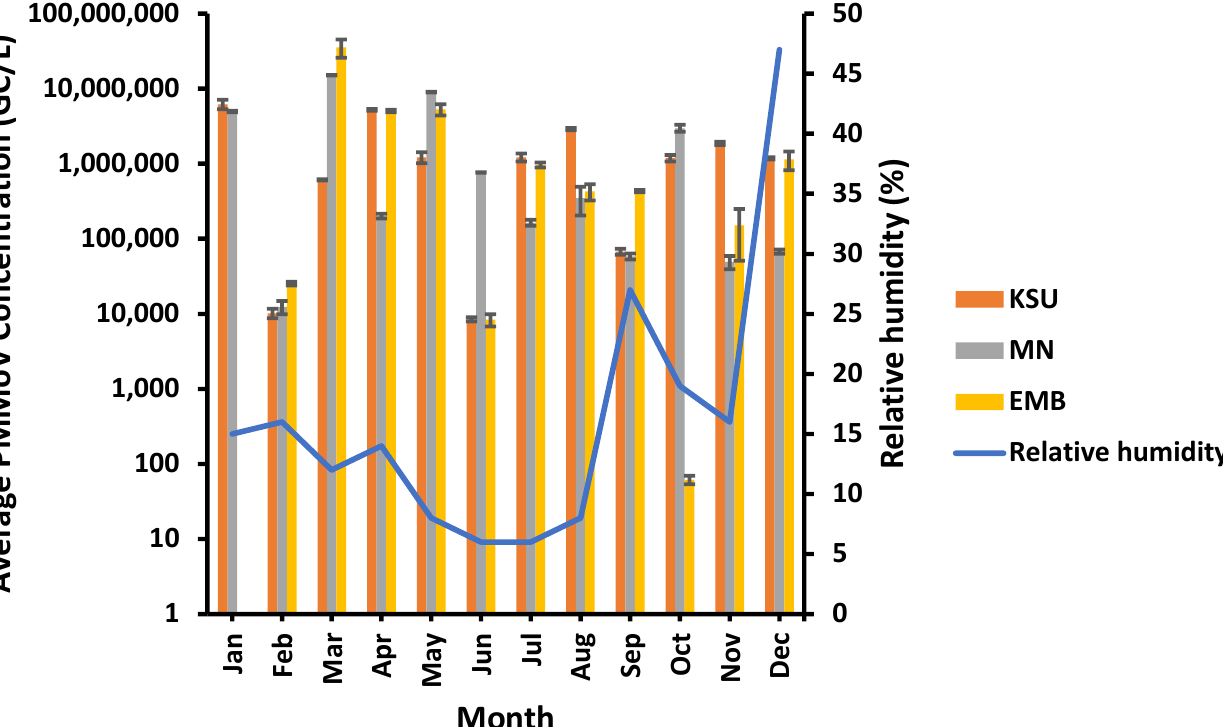
Figure 4. Relative humidity impact on the PMMoV concentration in raw water samples.